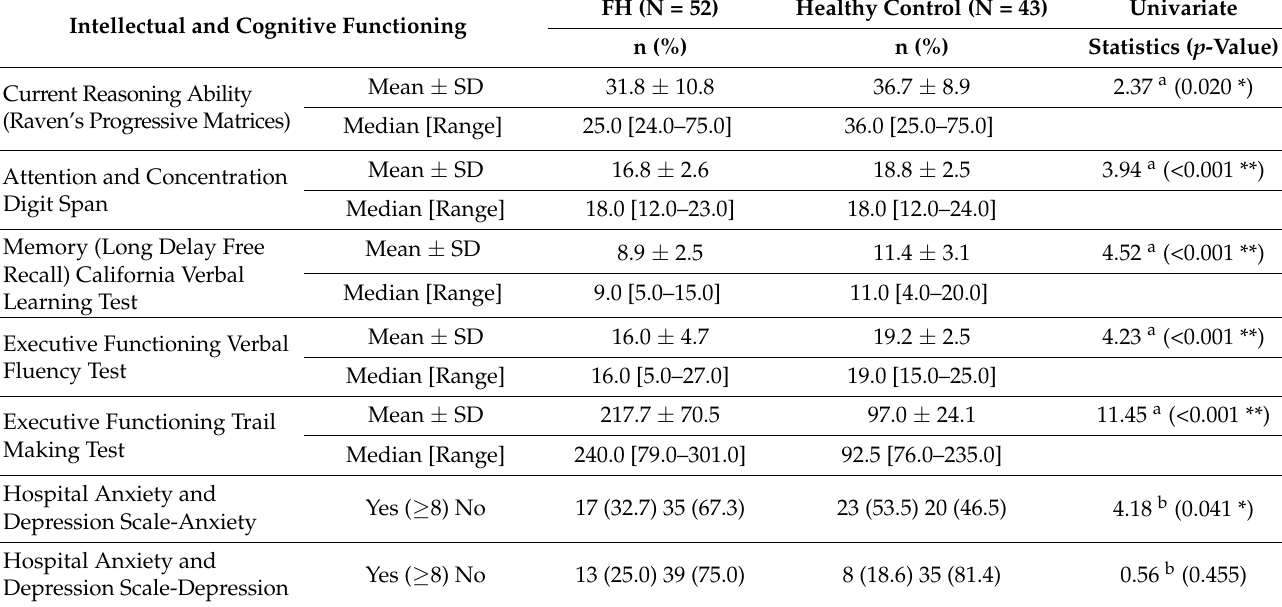
Table 2. Univariate analysis to compare the Intellectual capacity, cognitive and affective functioning outcomes between the FH patients (n = 52) and healthy controls (n =